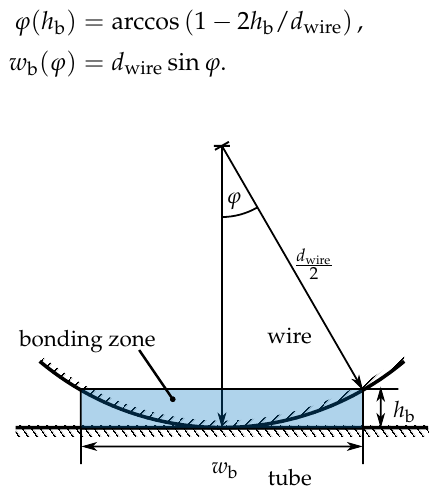
Figure 6. Model of the diffusion bonding zone between tubes and